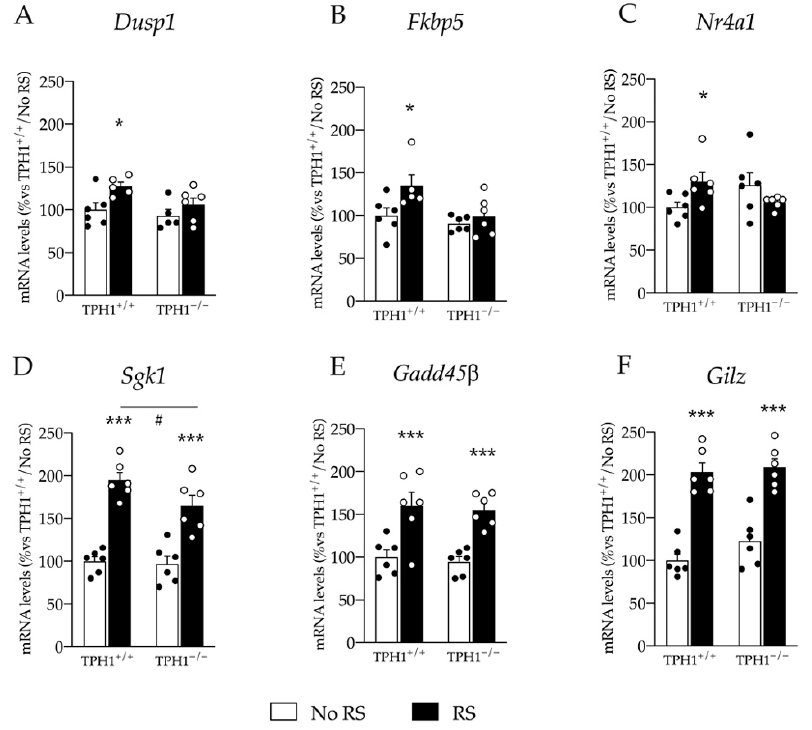
Figure 7. Analyses of Dusp1 ( A ), Fkbp5 ( B ), Nr4a1 ( C ), Sgk1 ( D ), Gadd45 β ( E ) and Gilz ( F ) mRNA levels in the PFC of TPH1 +/+ and TPH1 − / − male adult rats exposed to RS and sacrificed immediately after stress. The data, expressed as percentage of TPH1 +/+ /No RS (set at 100%), are the mean ± standard error of the mean (SEM) of at least 5 independent determinations. * p < 0.05; *** p < 0.001 vs. naïve for the same genotype; # p < 0.05 vs. TPH1 +/+ for the same condition; two-way ANOVA with Fisher’s PLSD.